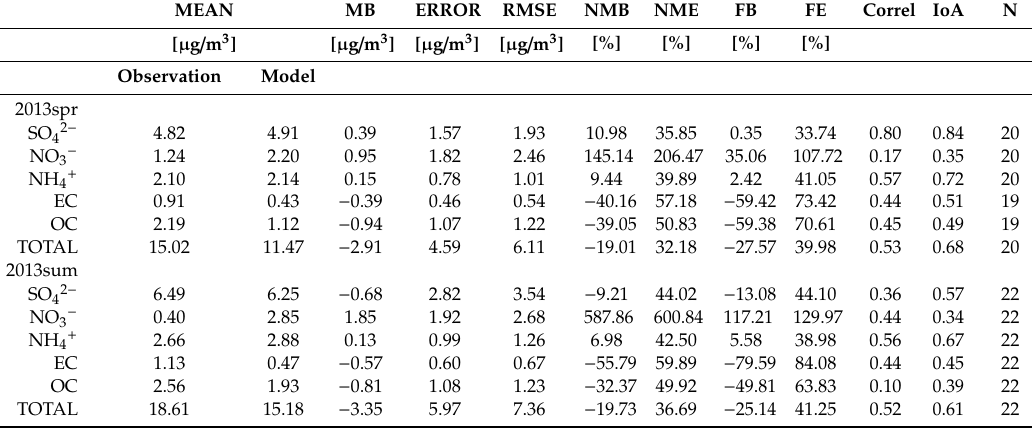
Table 5. Observed and simulated averaged concentrations 1 and ensemble performances 2 of the participant CTMs for daily concentrations of total PM 2.5 and PM 2.5 components at each AAPMS within